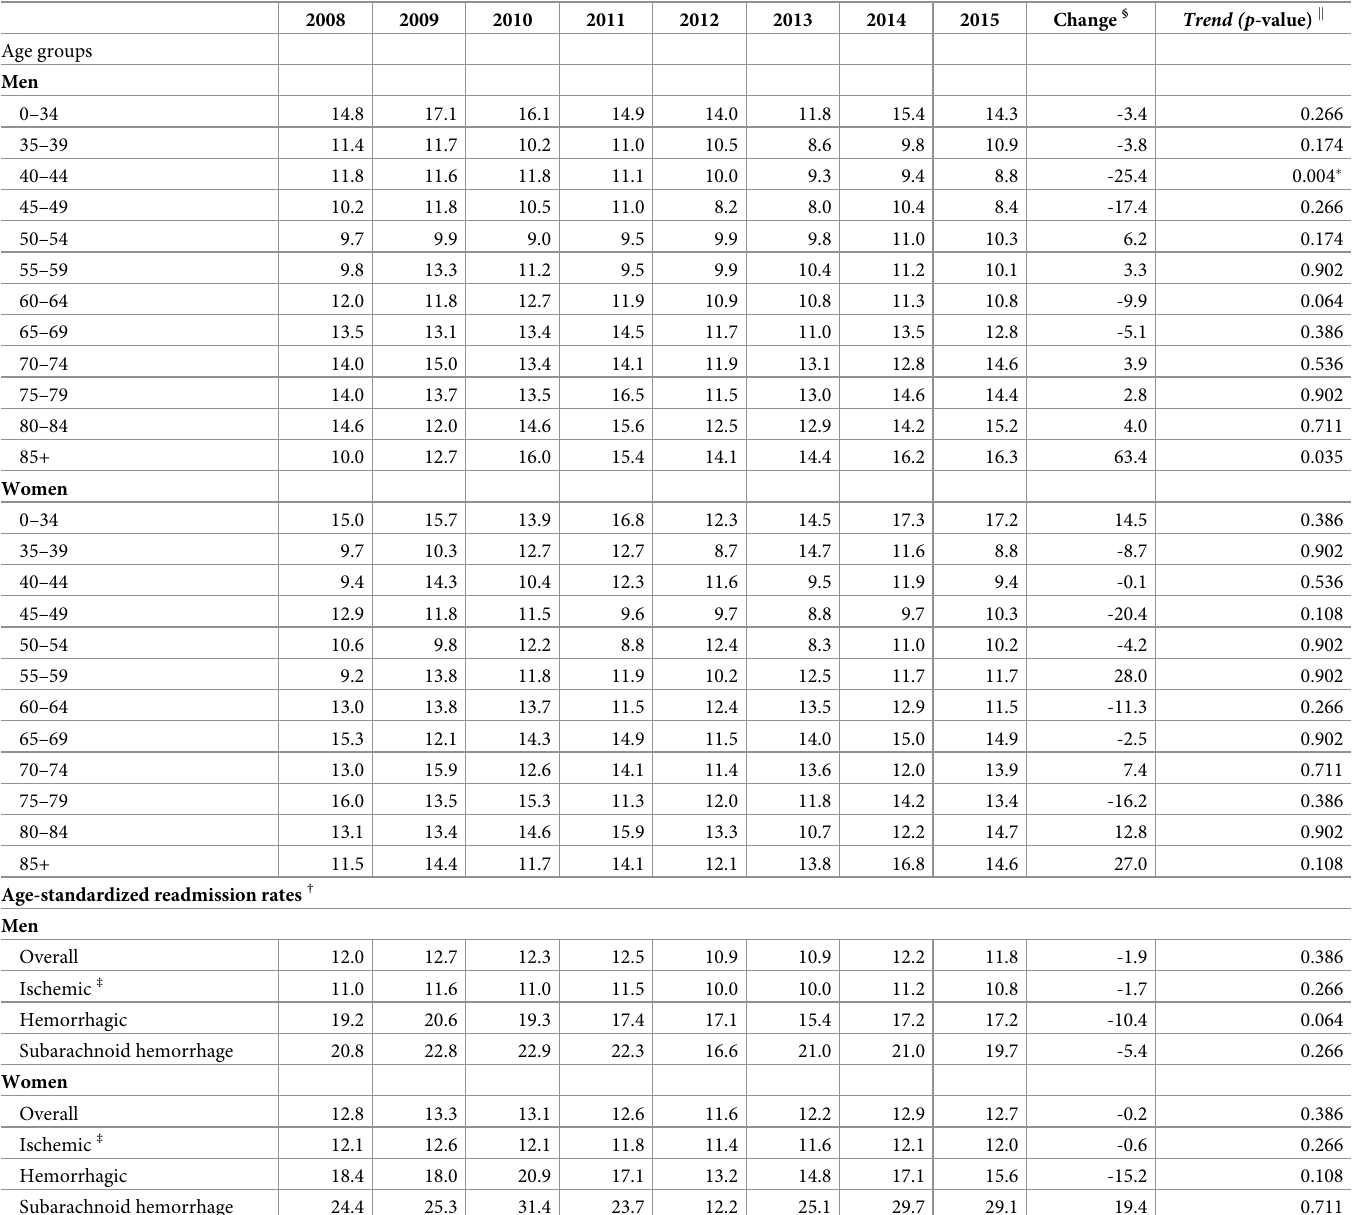
Table 2. Age-specific and age-standardized readmission rates by sex and stroke